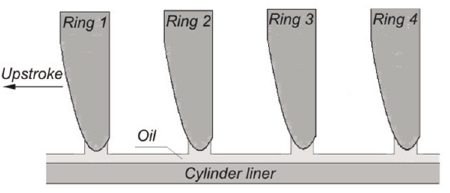
Fig. 6. Analysed profiles of the 1 st (top) piston ring: a) offset of the ring sliding surface O ff = 15 mm, b) offset O ff = 5 mm